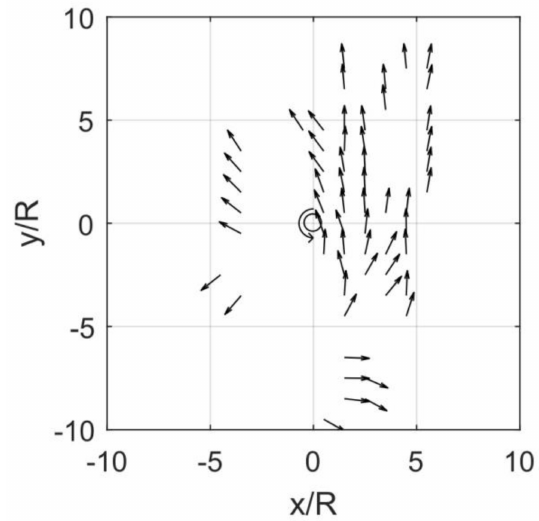
Figure 8. A composite of all of the data considered by Young [31] showing the mean values of the dominant wave direction in squares of size 1R × 1R. Areas with no vectors shown correspond to squares where there were insufficient measurements to form a reliable estimate of dominant wave direction. The tropical cyclone centre is shown by the open circle at co-ordinates (0, 0). The system is shown for the Northern Hemisphere (i.e., anti-clockwise